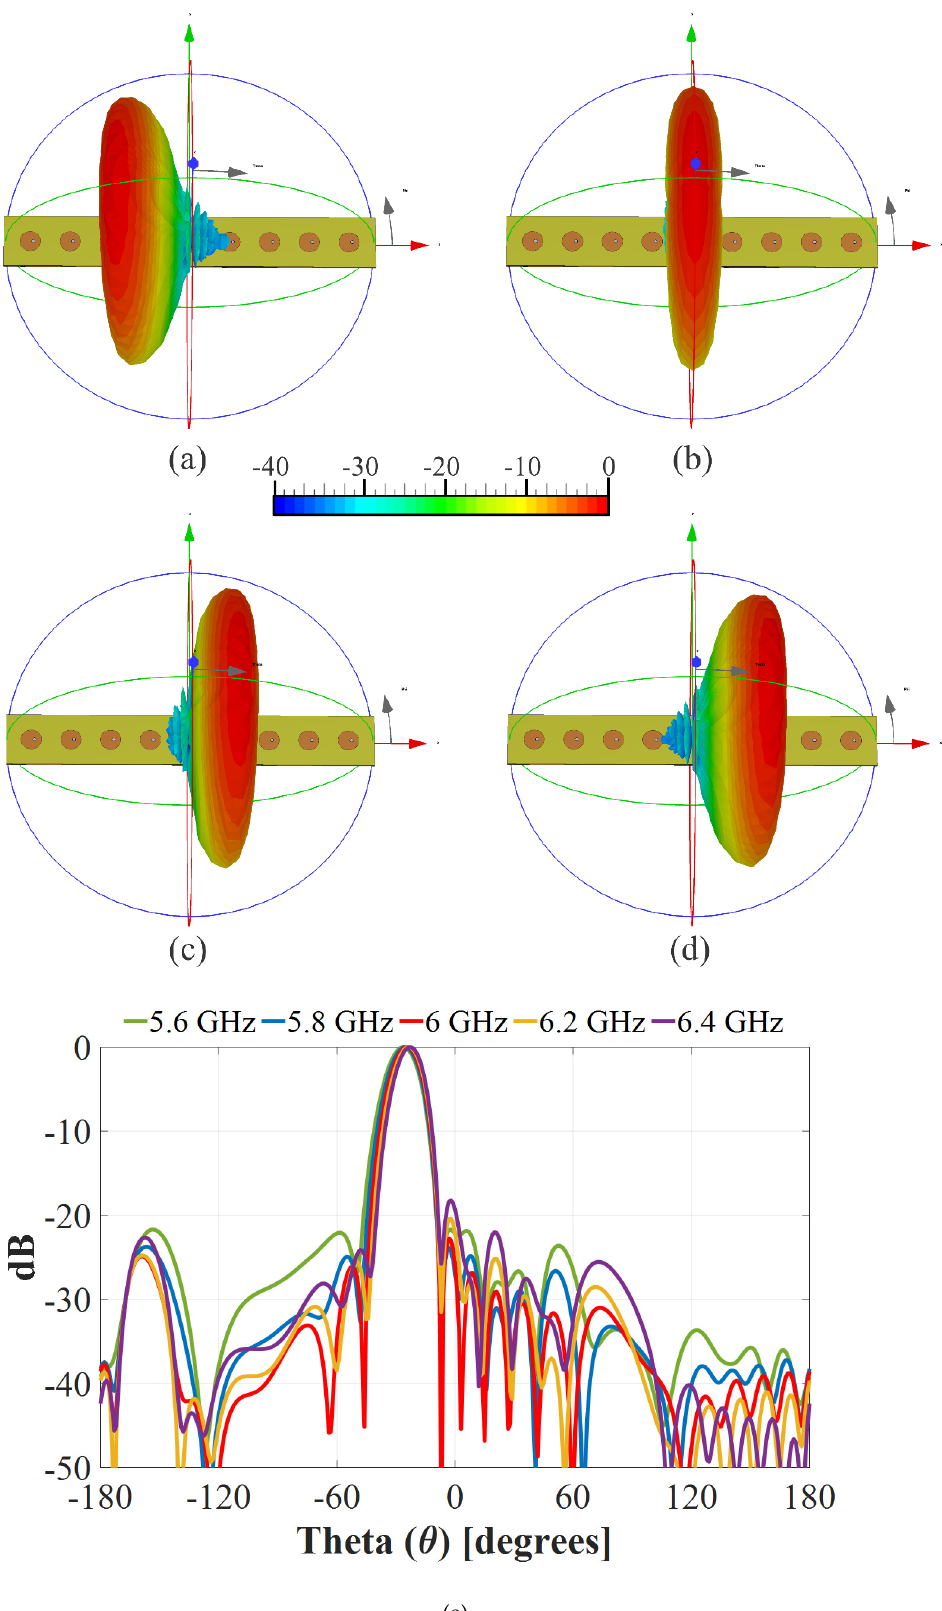
Figure 13. Radiation pattern obtained by CST simulations for ( a ) θ 0 = − 25 ◦ , ( b ) θ 0 = 0 ◦ , ( c ) θ 0 = 15 ◦ , and ( d ) θ 0 = 25 ◦ and ( e ) measured experimentally for the complete